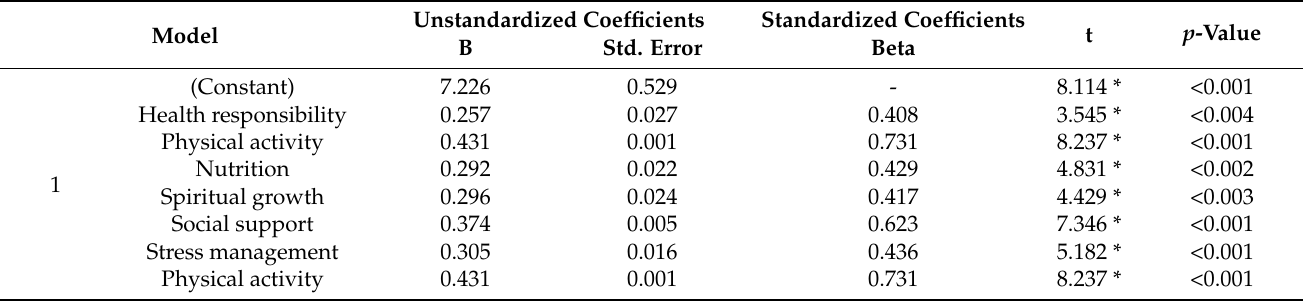
Table 8. Physical activity coefficients of EGa for multiple regression model